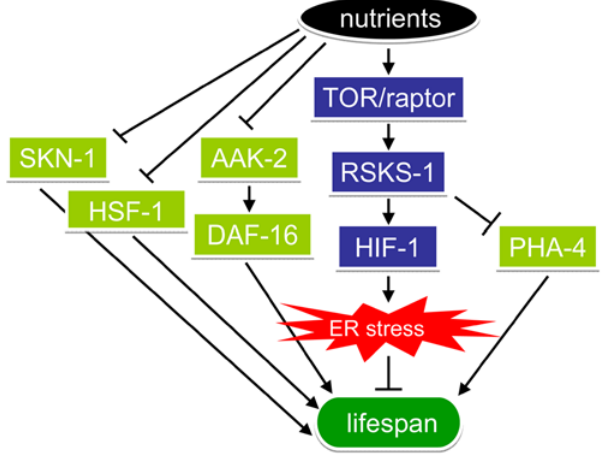
Figure 7. A genetic model depicting the modulation of lifespan by nutrients, HIF-1 and ER stress in C.elegans . High nutrients activate HIF-1 through the TOR-S6K pathway, which leads to increased ER stress and shortened lifespan. Other regulators such as PHA-4, SKN-1, AAK-2, DAF-16 and HSF-1 may function in parallel to HIF-1 to modulate DR-induced longevity